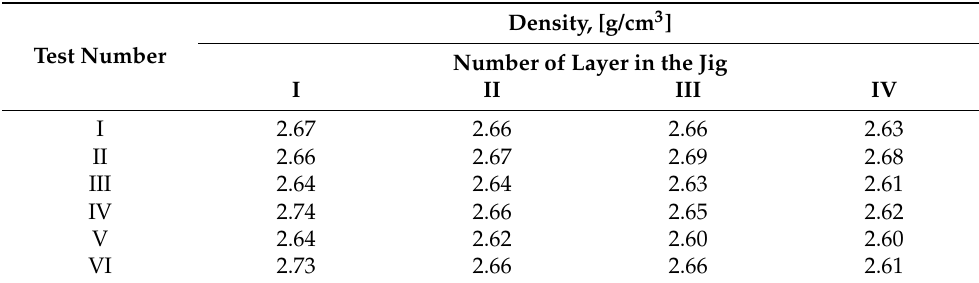
Table 4. Summary results of separation achieved in laboratory tests-density.